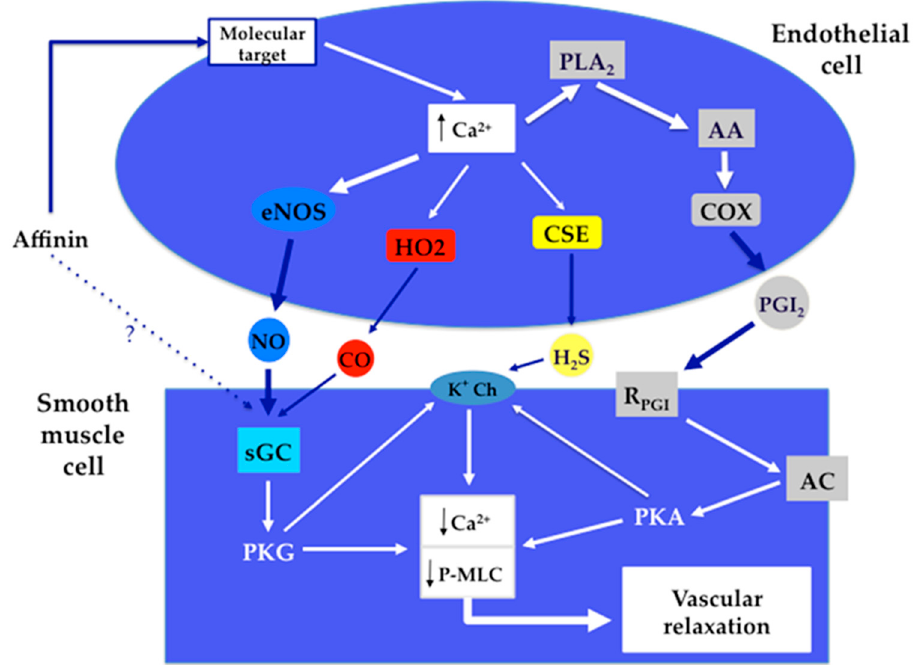
Figure 6. Pathways involved in the vasodilator effect of affinin. PLA 2 , phospholipase A 2 ; AA, arachidonic acid; COX, cyclooxygenase; eNOS, endothelial NO synthase; HO2, heme-oxygenase 2; CSE, cystathionine- γ -lyase; sGC, soluble guanylate cyclase; PKG, protein kinase G; AC, adenylate cyclase; PKA, protein kinase A; K + Ch, K + channel; P-MLC, phosphorylated myosin light chain. Black upwards arrow, increased levels; Black downwards arrows, decreased levels. ?, pathway that remains to be confirmed.